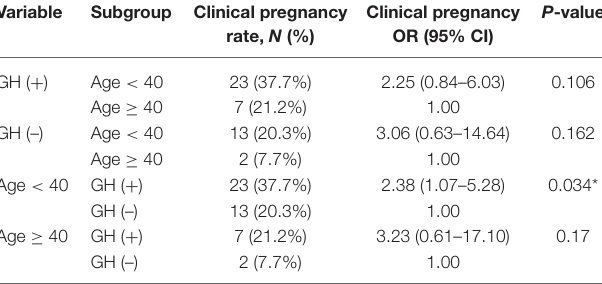
TABLE 4 | Clinical parameters and outcomes of poor-responder with GH co-treatment and normal-responder without GH co-treatment groups. PR with GH ( + ) NR with GH